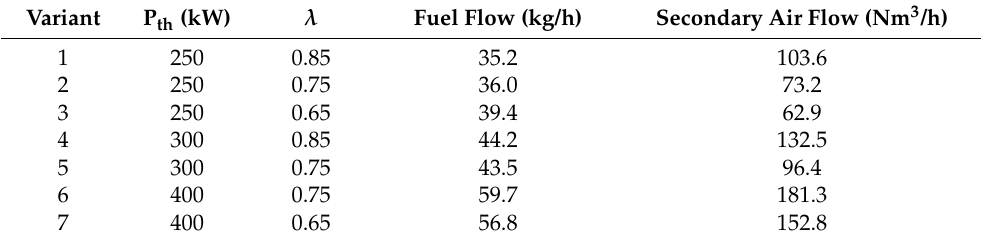
Figure 1. Overview of the camera mounting in the combustion chamber. During the tests, co-firing of mixtures of pulverized coal and biomass in the form of crushed straw was carried out, with different air and fuel proportions. The measurements were made at a constant fuel flow so that the calculated thermal output of the burner (P th ) was kept constant. The amount of incoming air was regulated, which affected the value of the excess air coefficient ( λ ). During the co-firing of the mixture of pulverized coal and biomass, the total combustion took place for λ ≈ 0.75; therefore this value of the excess air coefficient was considered the value corresponding to the "normal" combustion conditions. On this basis, three values of the λ coefficient were adopted in the studies. The first corresponded to normal conditions ( λ = 0.75). The second value corresponded to the insufficient air ( λ = 0.65), and the third to its excess ( λ = 0.85). The tests were carried out for seven combustion variants, with different P th and λ and where coal mixture with 10% of biomass (straw) has been examined (Table 1). Table 1. Variants of the combustion process. P th —thermal power, λ —excess air coefficient.